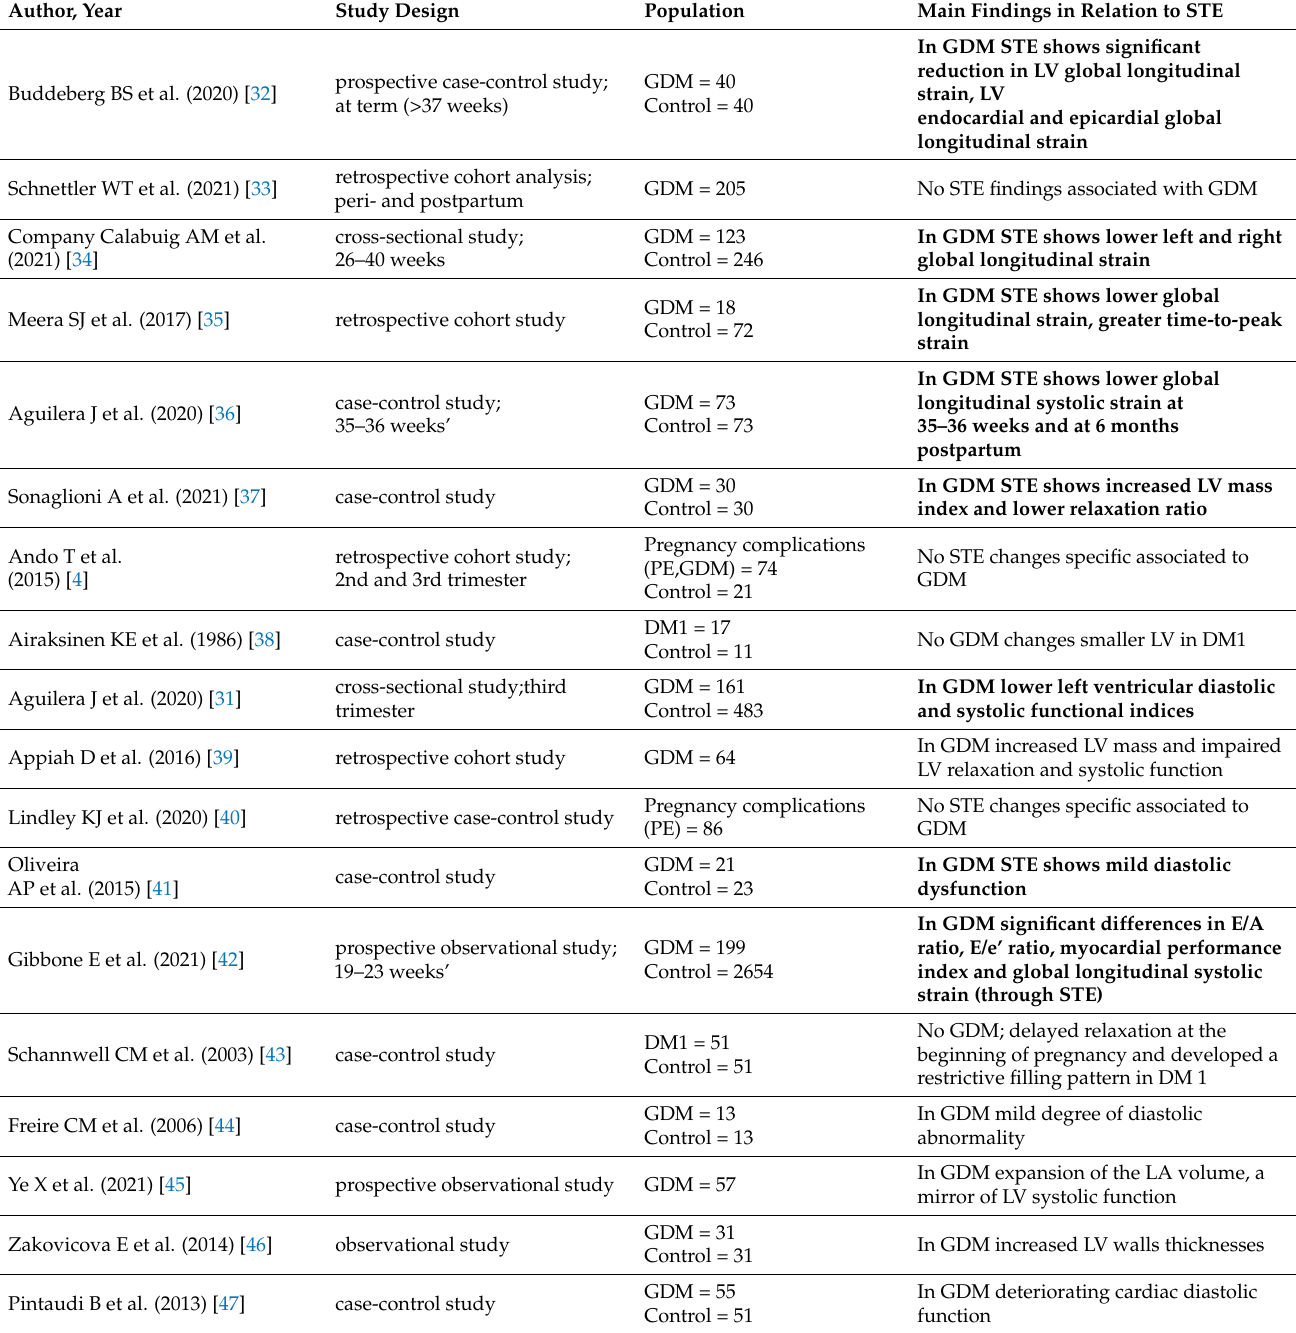
Table 1. Studies assessing maternal cardiac function in gestational diabetes. DM 1-diabetes mellitus type 1, GDM-gestational diabetes mellitus, LV-left ventricle, STE-speckle tracking echocardiography. In bold, significant STE